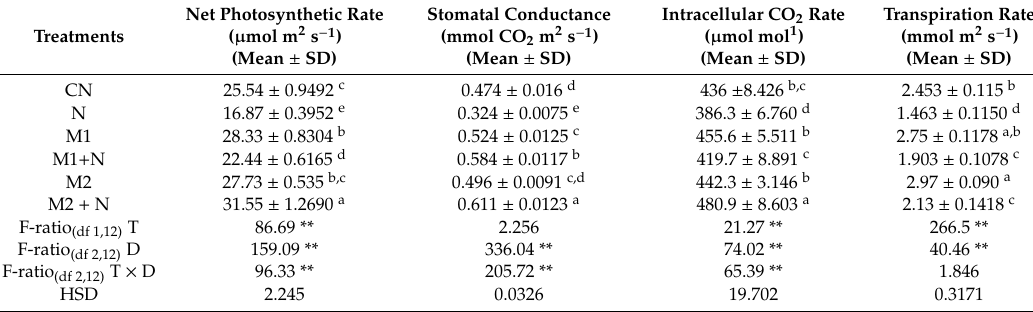
Table 2. Effect of M1 (10 9 cells / mL) and M2 (10 9 cells / mL) on gas exchange parameters a net photosynthetic rate, b stomatal conductance, c intracellular CO 2 , d transpiration rate in 45-days old L. esculentum under PPN infection.